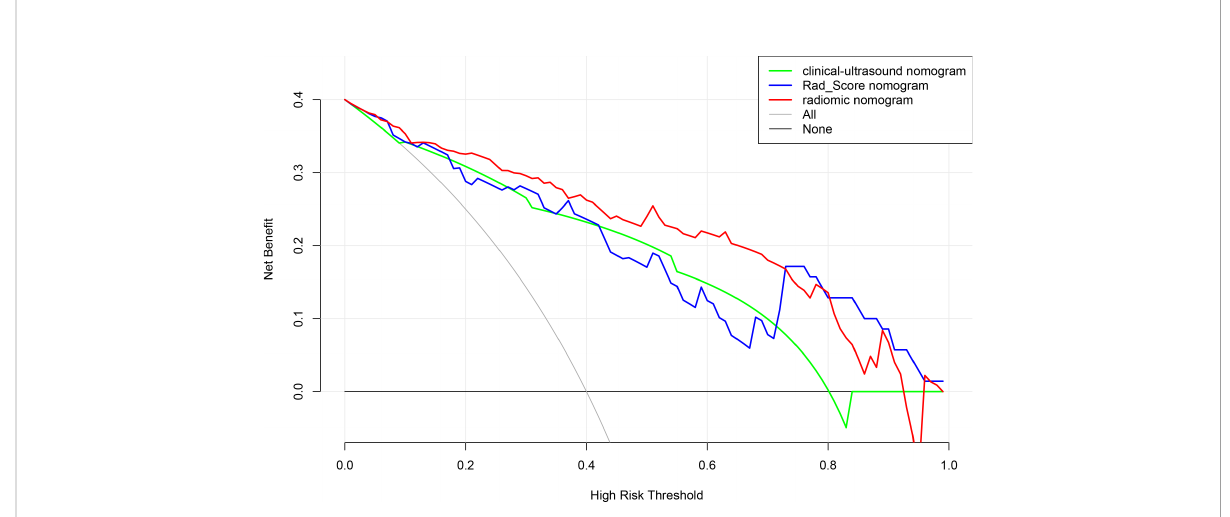
FIGURE 9 Decision curve analysis for clinical ultrasound nomogram,the Rad-Score and radiomics model